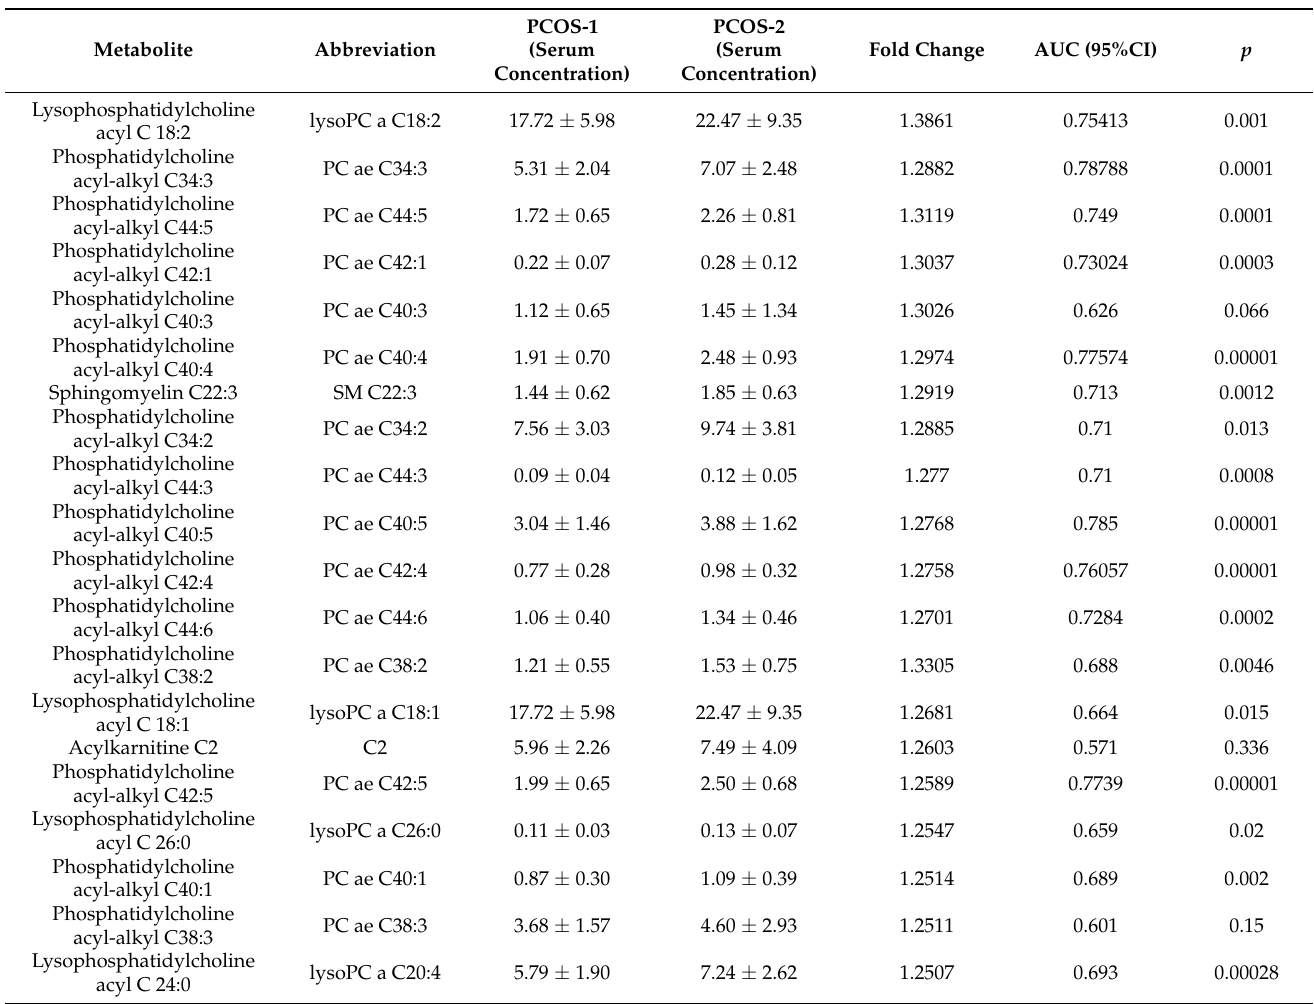
Table 5. Differentiating metabolites with serum concentrations determined between PCOS-1 and PCOS-2 (mean ± SD, uM) and results from univariate